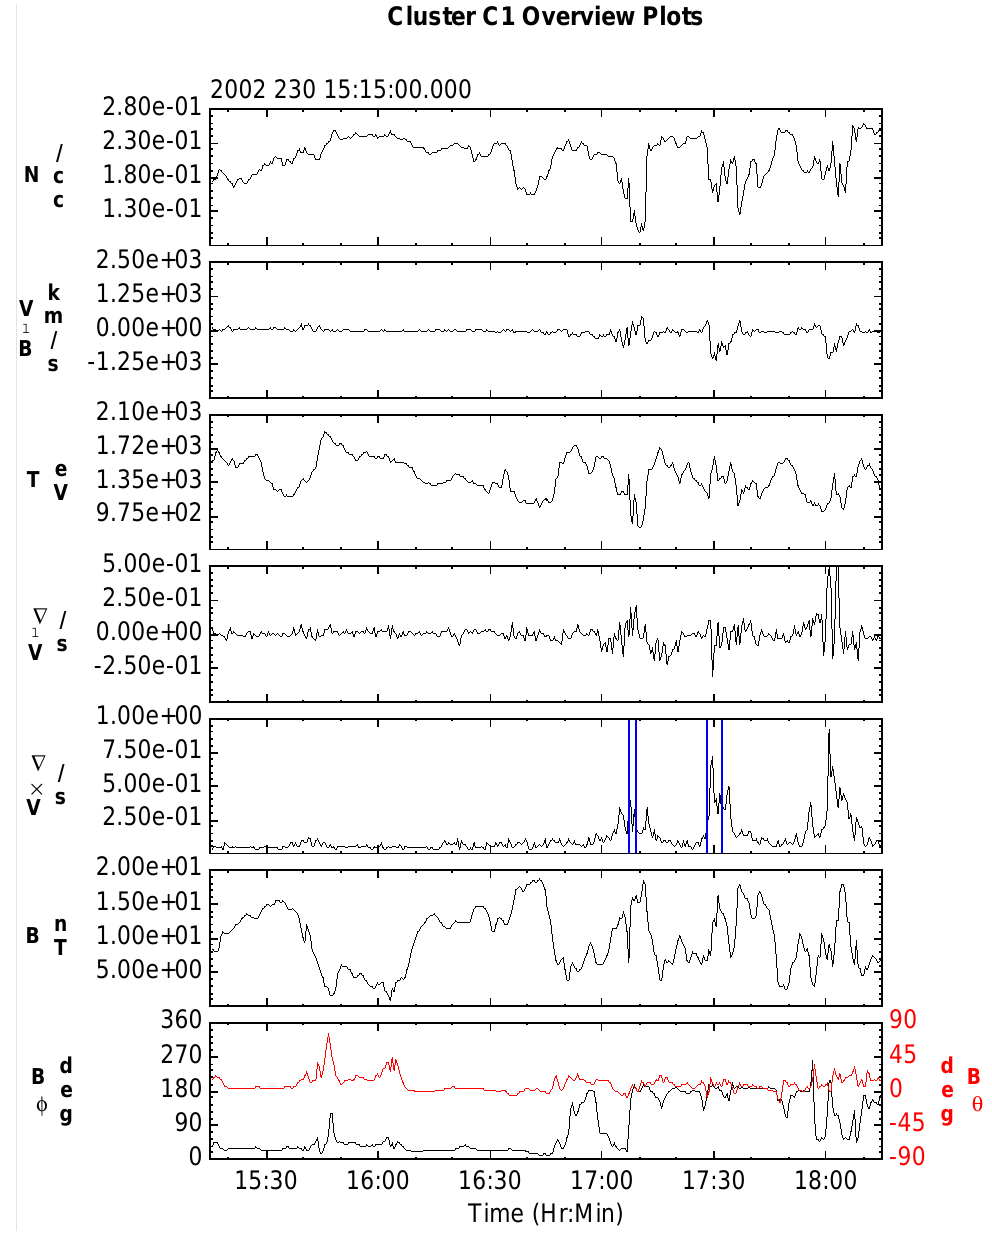
Fig. 1. Overview of the tail crossing on 17 August 2002 (Event 2). From top to bottom are shown the electron density, parallel velocity, temperature, divergence of the velocity, magnitude of the vorticity, total magnetic field, and the polar angles of the magnetic field vector in GSM. With the exception of the divergence and vorticity, which use all four spacecraft, the data shown were obtained from C1. Blue lines in panel 5 demarcate times when the spacecraft made known crossing of an ion diffusion region (Eastwood et al.,